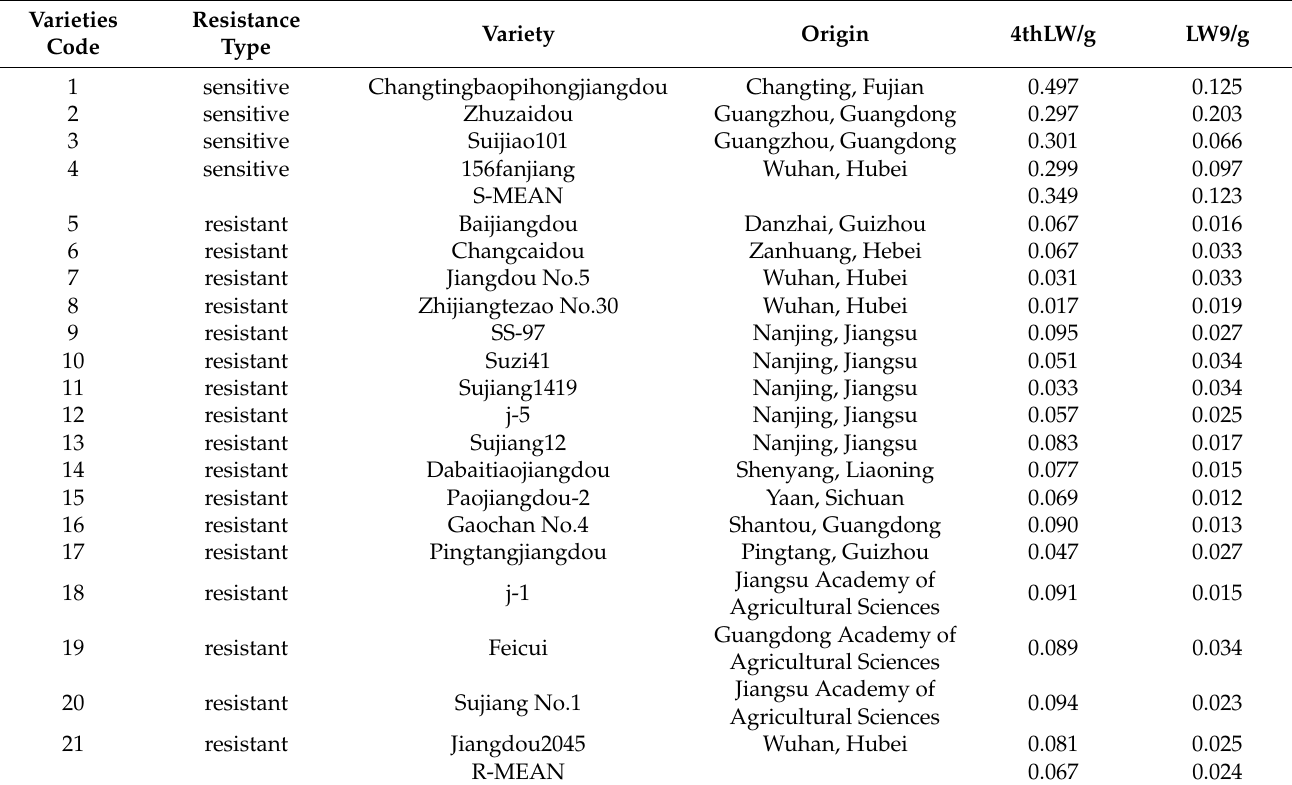
Table 1. Insect-sensitive or resistant yardlong bean varieties screened by evaluation of newly hatched larvae and 4th instar larvae weight